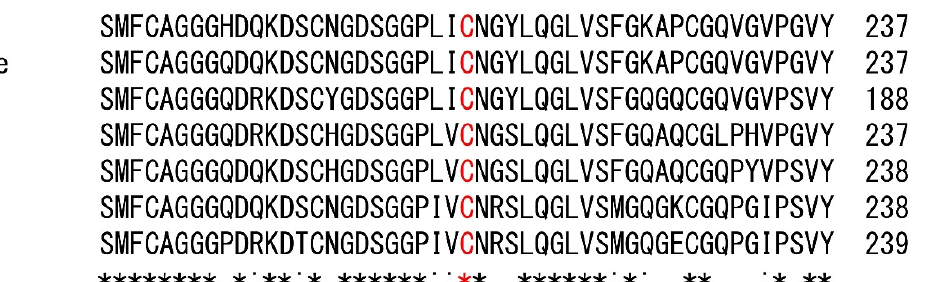
Figure 3. Sequence alignment of vertebrate orthologs. The asterisk indicates complete conservation.